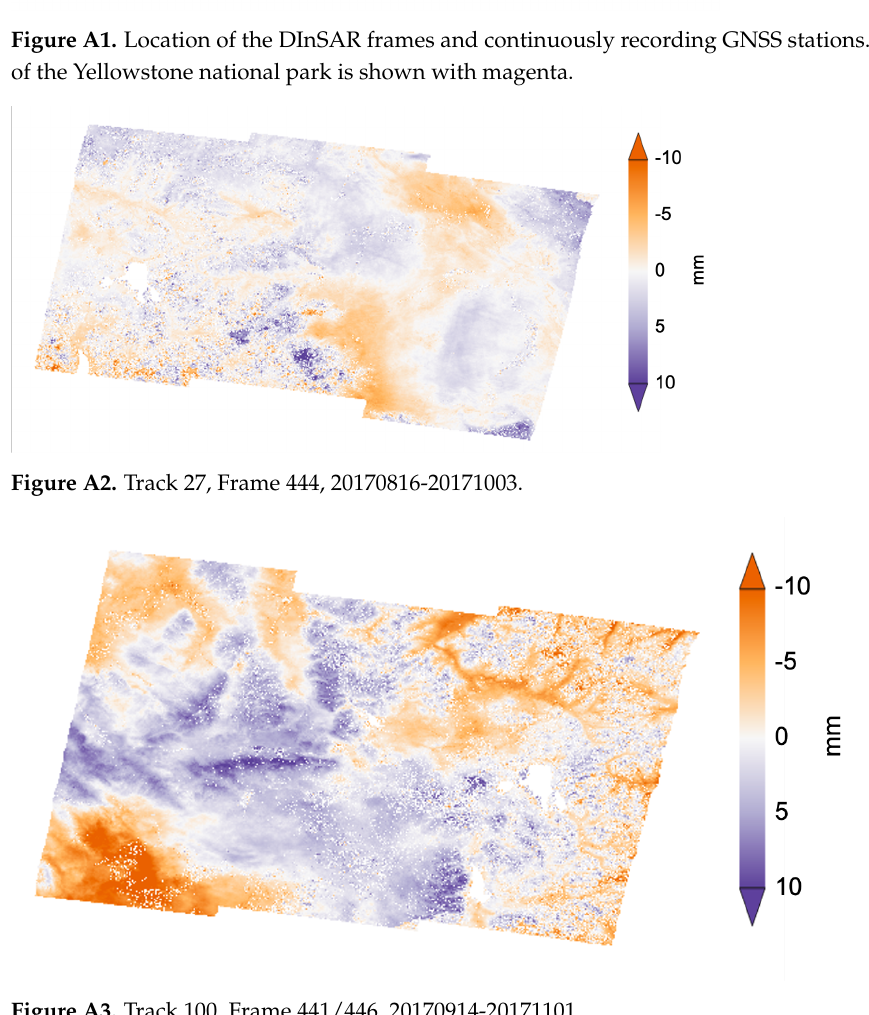
Figure A3. Track 100, Frame 441/446,